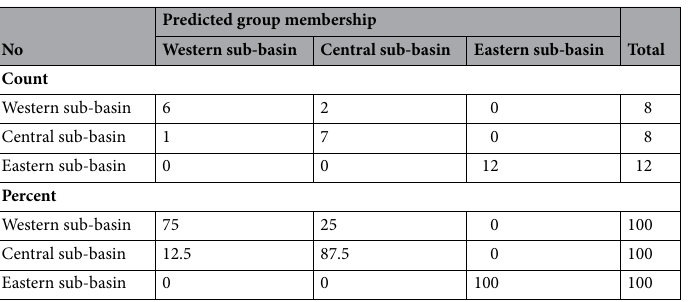
Table 2. Classification results for the three sub-basin spatial sediment sources using stepwise